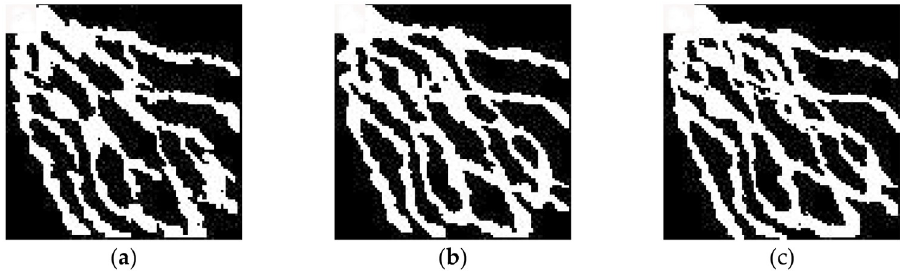
Fig 10. Comparison of the results obtained with different numbers of conditional data points: (a) 350; (b) 450; (c) 550.